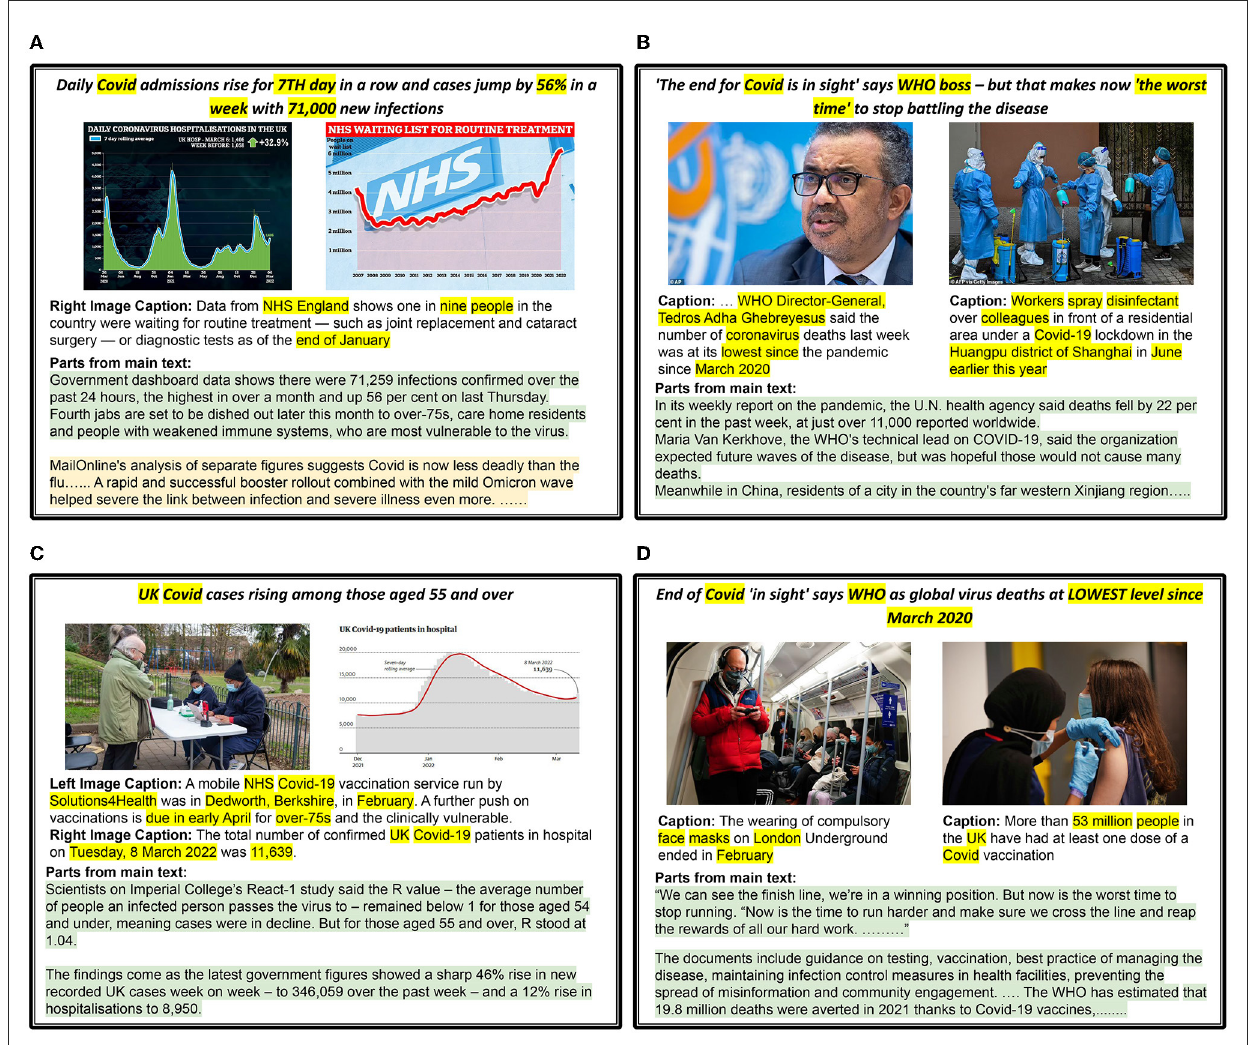
FIGURE13 Examples of news articles on COVID-19 with multiple images, captions and parts from the main text. Left and right column news are from 10 th March and 15 th September 2022, respectively. Yellow highlighted text - refers to entities/concepts and news values clues. Green highlighted text